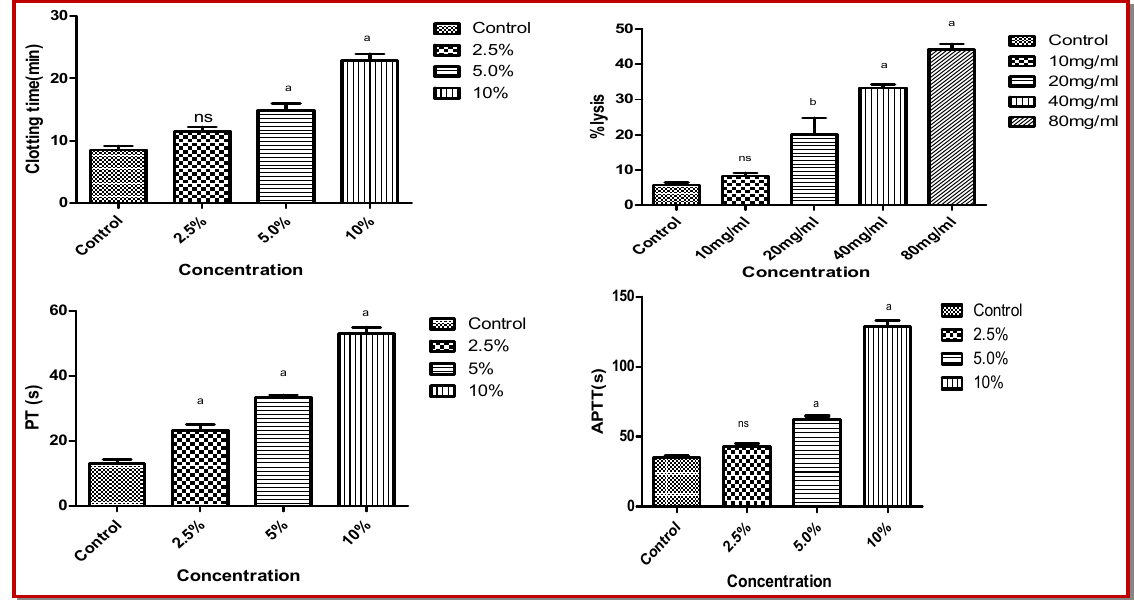
Figure 1: Effect of aqueous methanolic extract of M. longifolia on clotting time (A), clot lysis (B), prothrombin time (C), and activated partial thromboplastin time (D) of rabbit blood; ns = non significant and a p<0.001, b